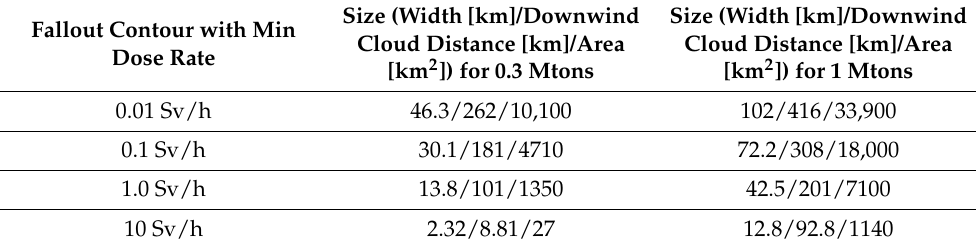
Table 4. Radioactive fallout based on the NukeMap simulator for 0.3 and 1